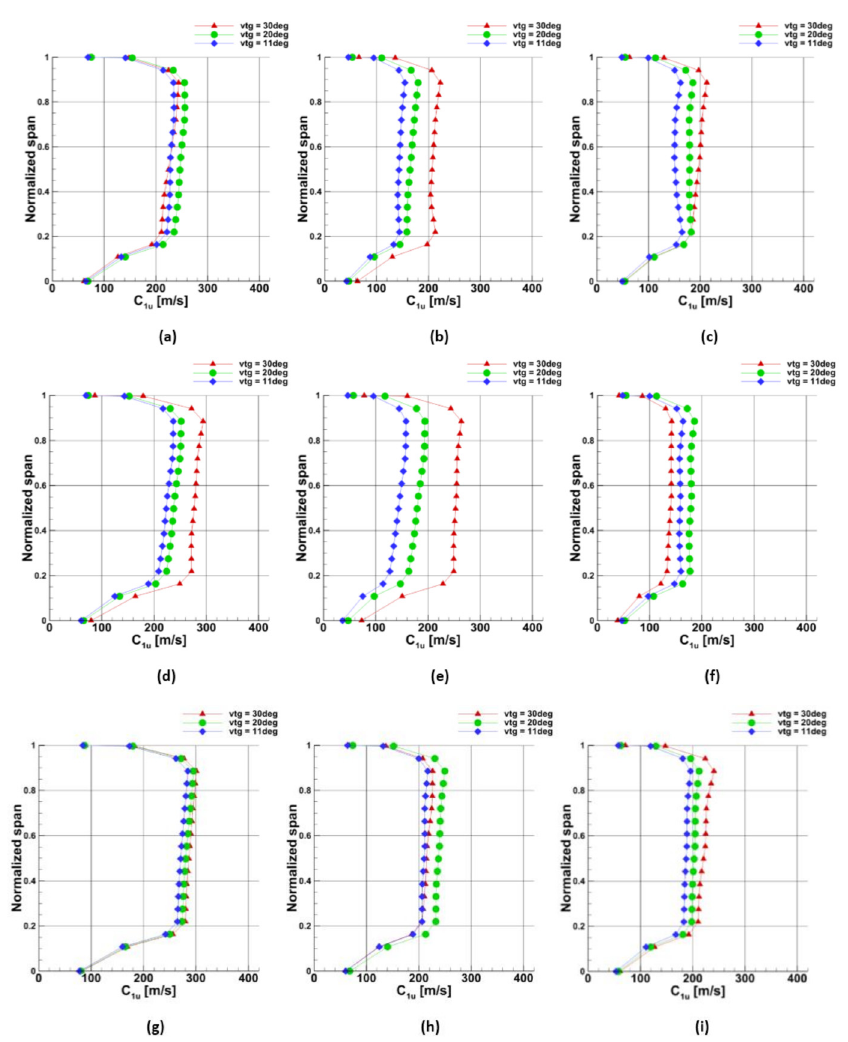
Figure 27. The plots of the tangential component of the absolute velocity C 1 u measured behind the 1st stage nozzle vane against the blade height for: ( a – c ) 60,000 rpm point A, B, C respectively, ( d – f ) 50,000 rpm point A, B, C respectively, ( g – i ) 40,000 rpm point A, B, C